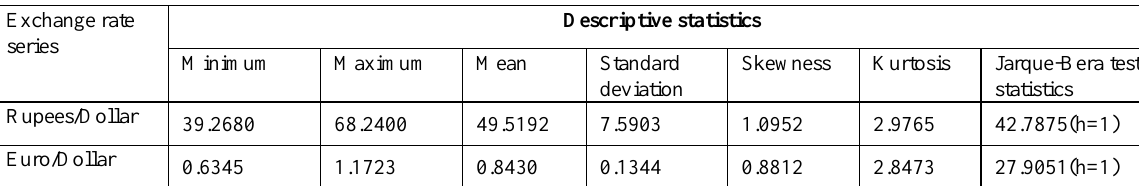
Table 2 Descriptive statistics of exchange rates series from five